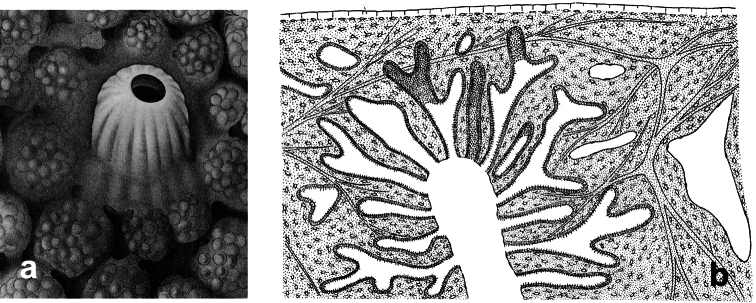
Halisarca dujardini. a drawing of the sponge surface with an osculum b the typical architecture of the aquiferous system. a modified from Schulze (1877) b modified from von Lendenfeld (1889).